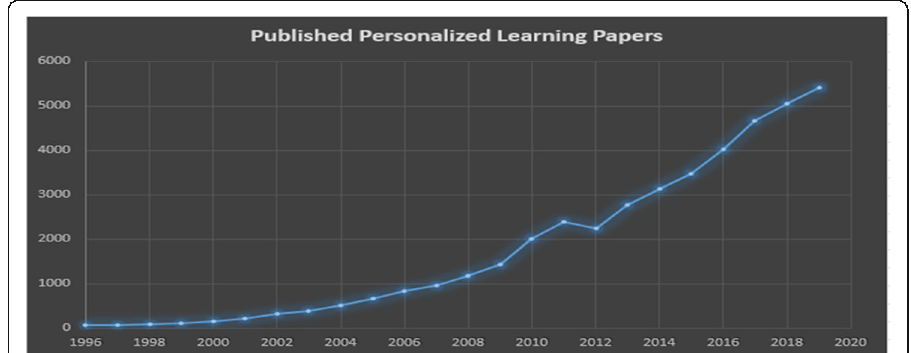
Fig. 1 The number of published papers on “ personalized learning